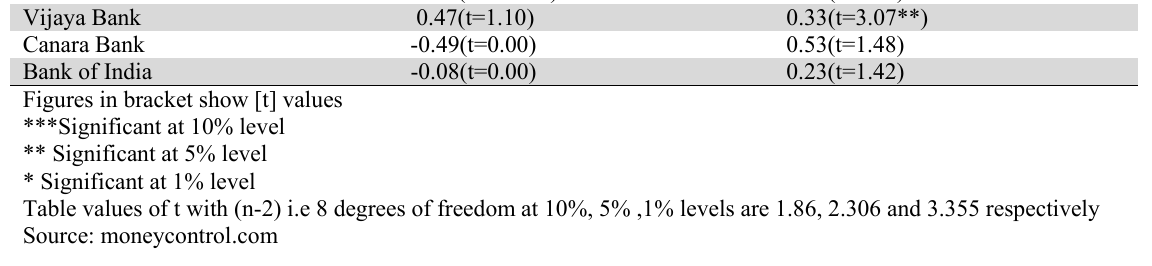
Table values of t with (n-2) i.e 8 degrees of freedom at 10%, 5% ,1% levels are 1.86, 2.306 and 3.355 respectively Source: moneycontrol.com